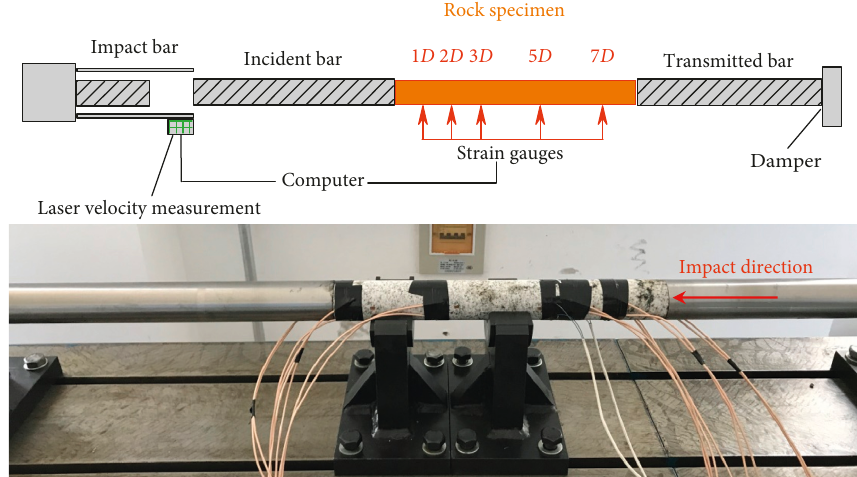
Figure 3: Dynamic strain monitoring in the tests.